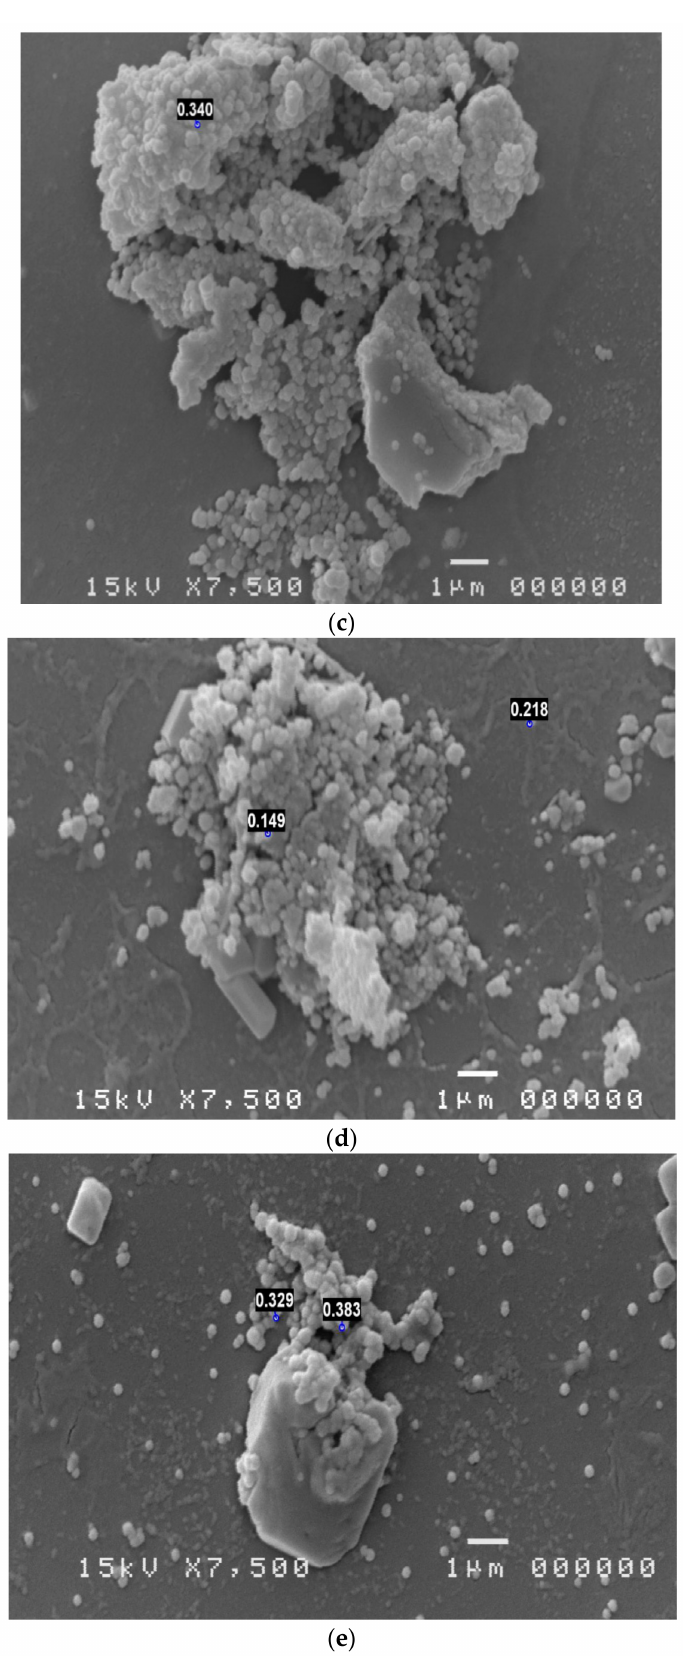
Figure 3. SEM Evaluation: Acanthamoeba ( a ), Candida ( b ), Chlamydia ( c ), Mycobacteria ( d ), My- coplasmas ( e